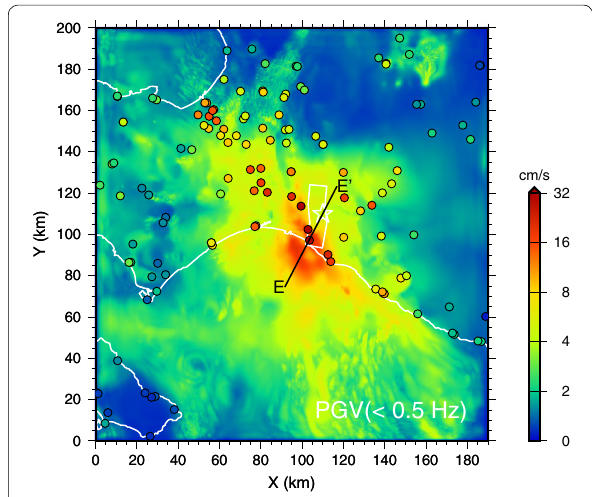
Fig. 11 Maps showing comparison between the simulated PGV (background color) and observed PGV (colored circles). Both of the simulated and observed waveforms were low-pass filtered at 0.5 Hz. The star indicates the